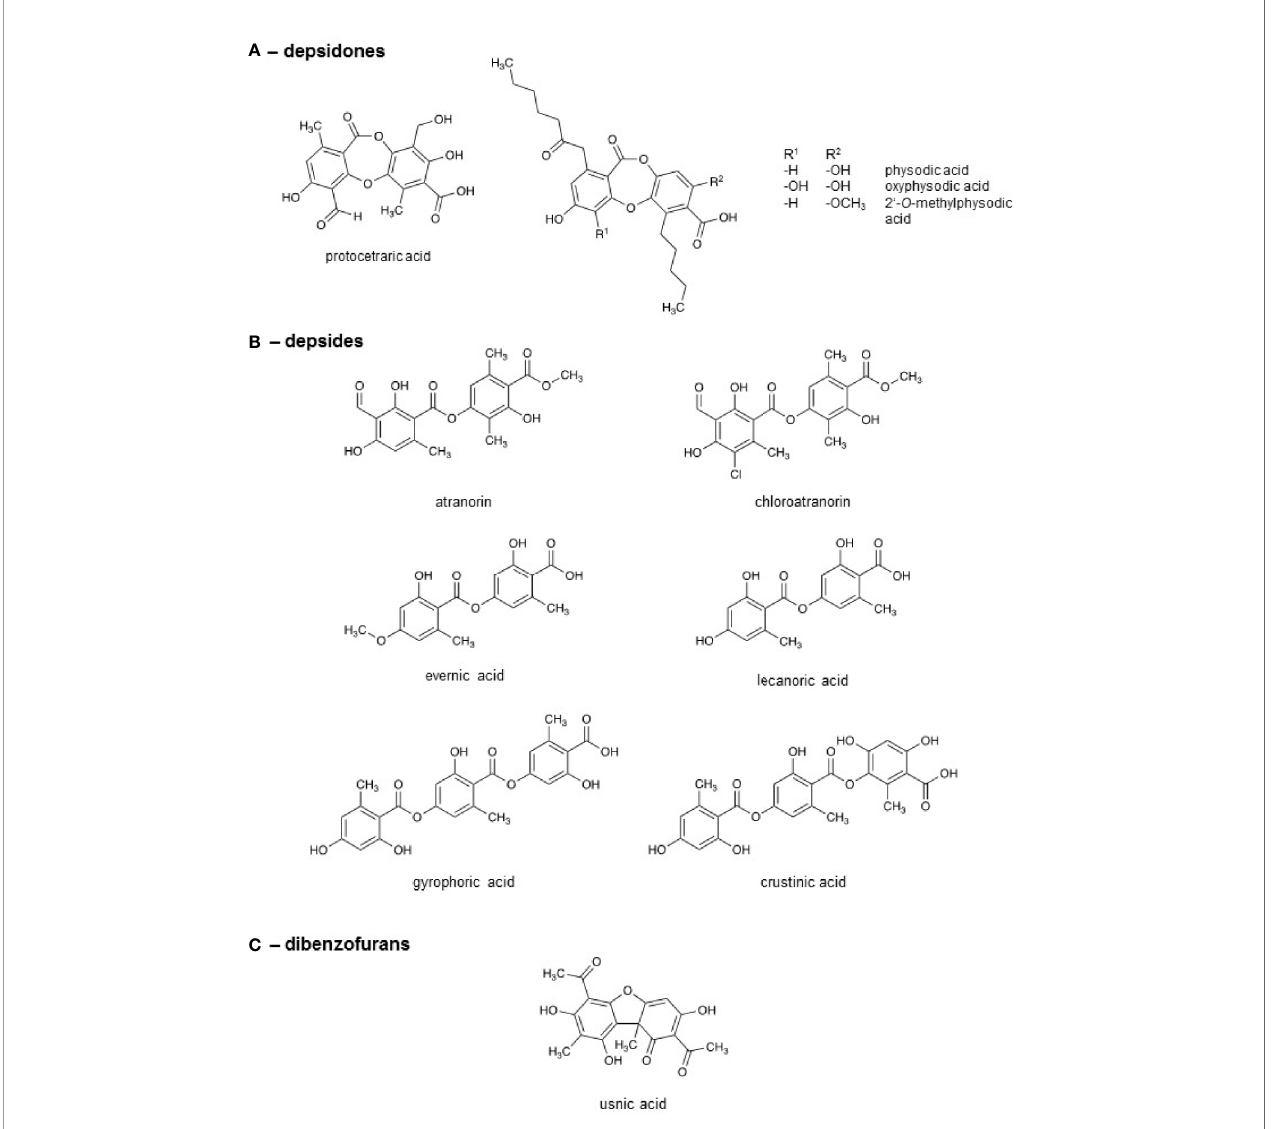
FIGURE 4 | Chemical structures of the lichen